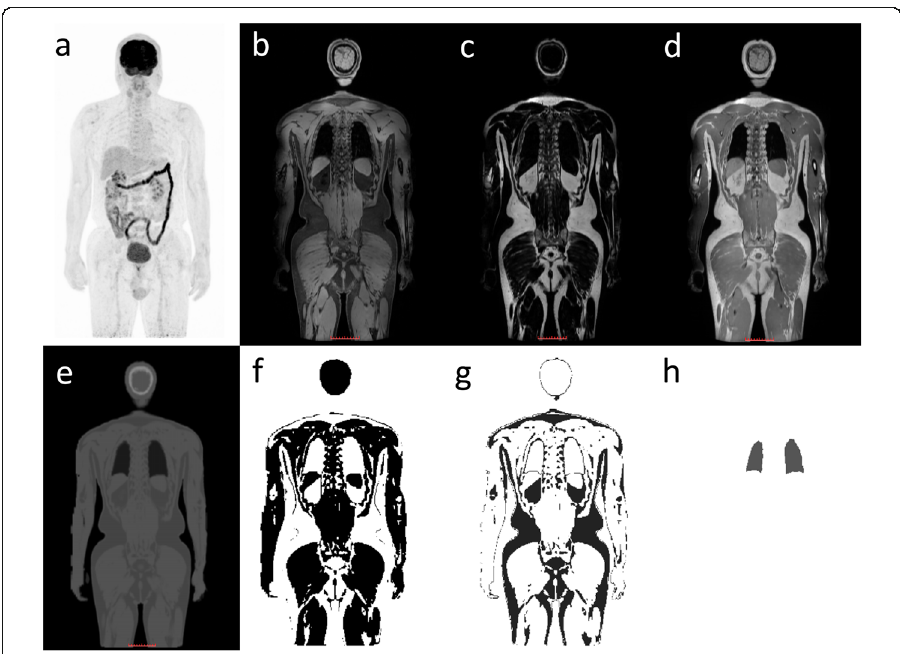
Fig. 2 Representative images from a 18 F-FDG PET/MR scan. a PET MIP, b water image, c fat image, d in- phase image, e MRAC map, f water segmented from MRAC, g fat segmented from MRAC, and h lung segmented from